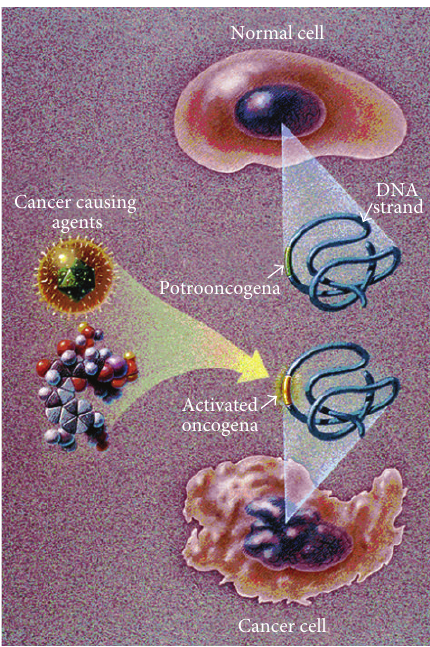
Figure 5: National Cancer Institute illustration shows the stages of how a normal round cell is converted to a cancer cell with shape irregularities for both the nuclear and plasma cell membranes when an oncogene becomes activated. (With permission from the National Institutes of Health/Department of Health and Human